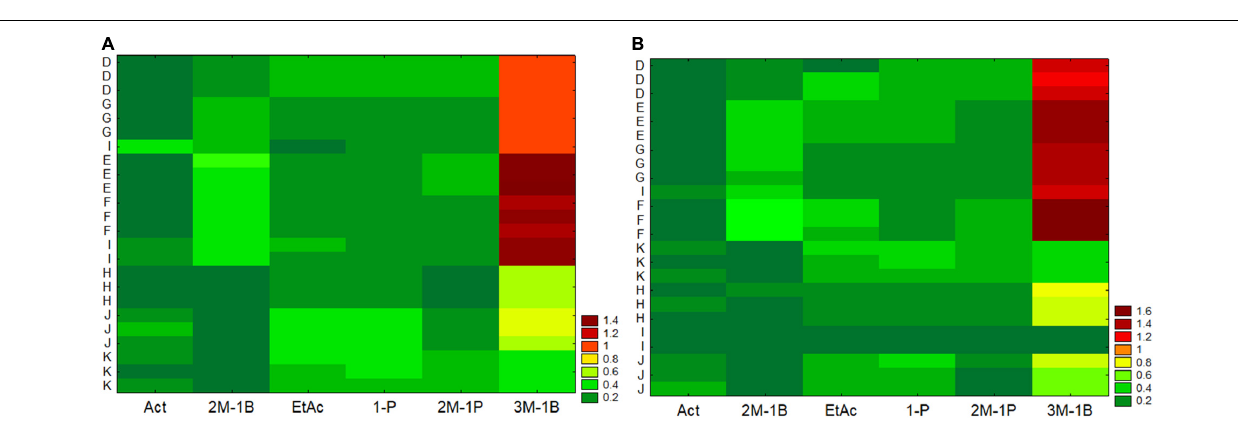
FIGURE 4 | Two-way joining of the main by-products formed in different grape musts by the strain EC (graph A ) and the strain AW (graph B ) and by eight RUs (D, E, F, G, H, I, J, and K). Act, acetaldehyde; 1-Pr, 1-propanol; 2M-1B, 2-methyl-1-butanol; EtAc, ethyl acetate; 2M-1P, 2-methyl-1-propanol; 3M-1B, 3-methyl-1-butanol; ppm per gram of consumed